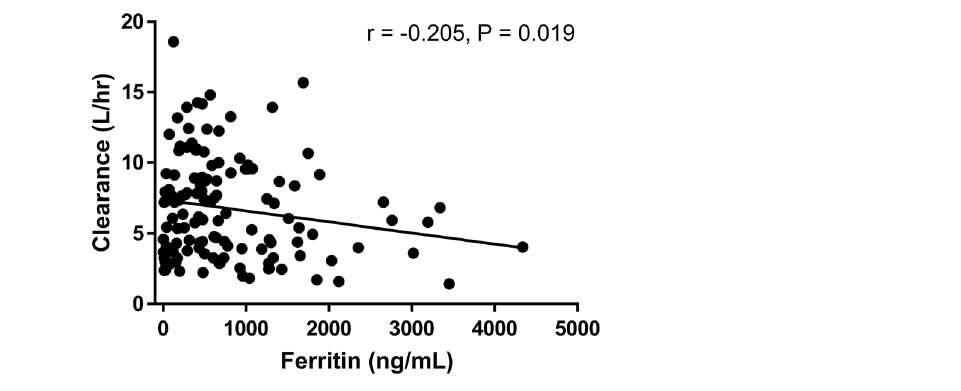
Figure 4. ( A ) The first day area under the curve (AUC) and ( B ) clearance showed gradual elevations or decreased along with the ferritin level when patients were divided into 4 groups as follows: ferritin <